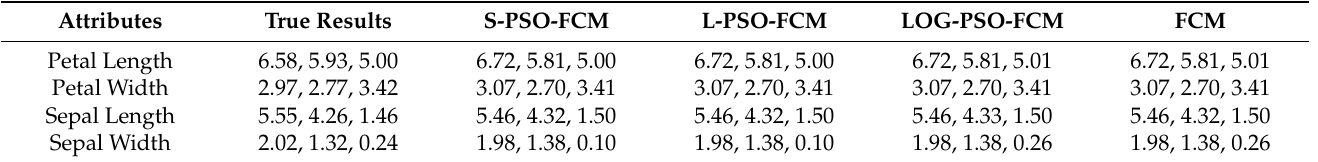
Table 2. Clustering